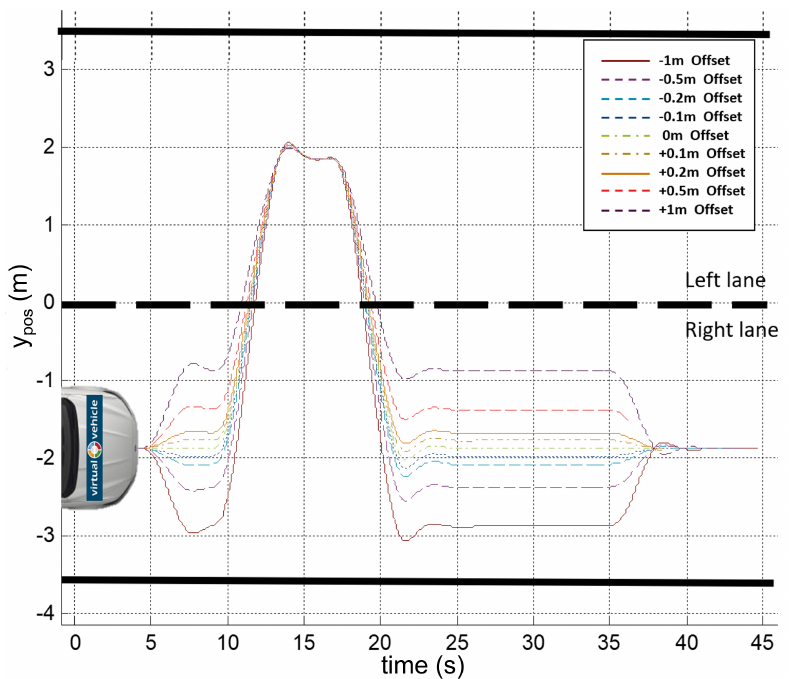
Figure 7. Combined in-lane off-set and lane change recommendations with varying lateral off-set values. The lane boundaries were shown to aid the